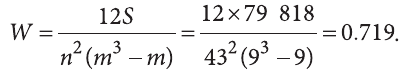
Fig. 1. Average ranks of operating AMP quality criteria (indices)